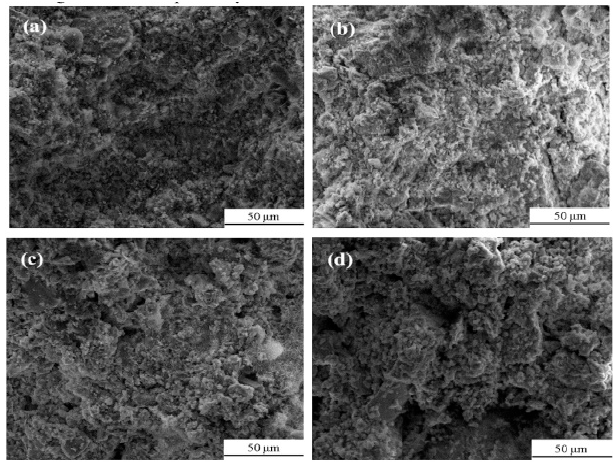
Figure 2. Variation of UCS fillings with different sulfur content [31].